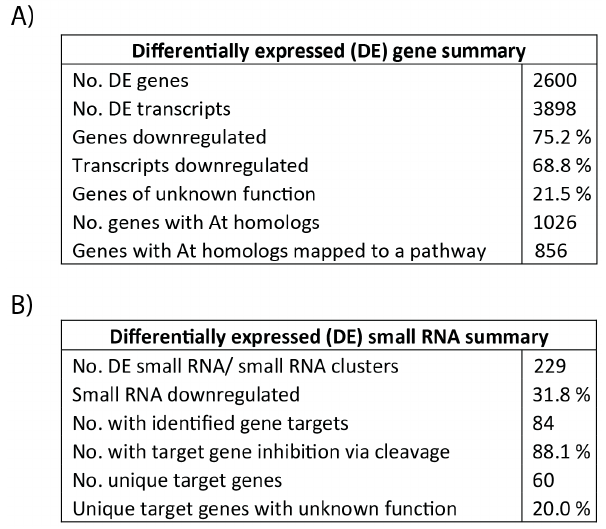
Figure 3. Summaries of differentially expressed genes ( A ) and small RNA ( B ) in potato tubers at 35% FC using a threshold of 4-fold difference in expression and a 5% FDR. Gene homologs in A. thaliana were considered if identity was greater than 50%. Functional annotation clustering to KEGG pathways was based on Arabidopsis gene IDs using the DAVID Bioinformatics online resource 6.8